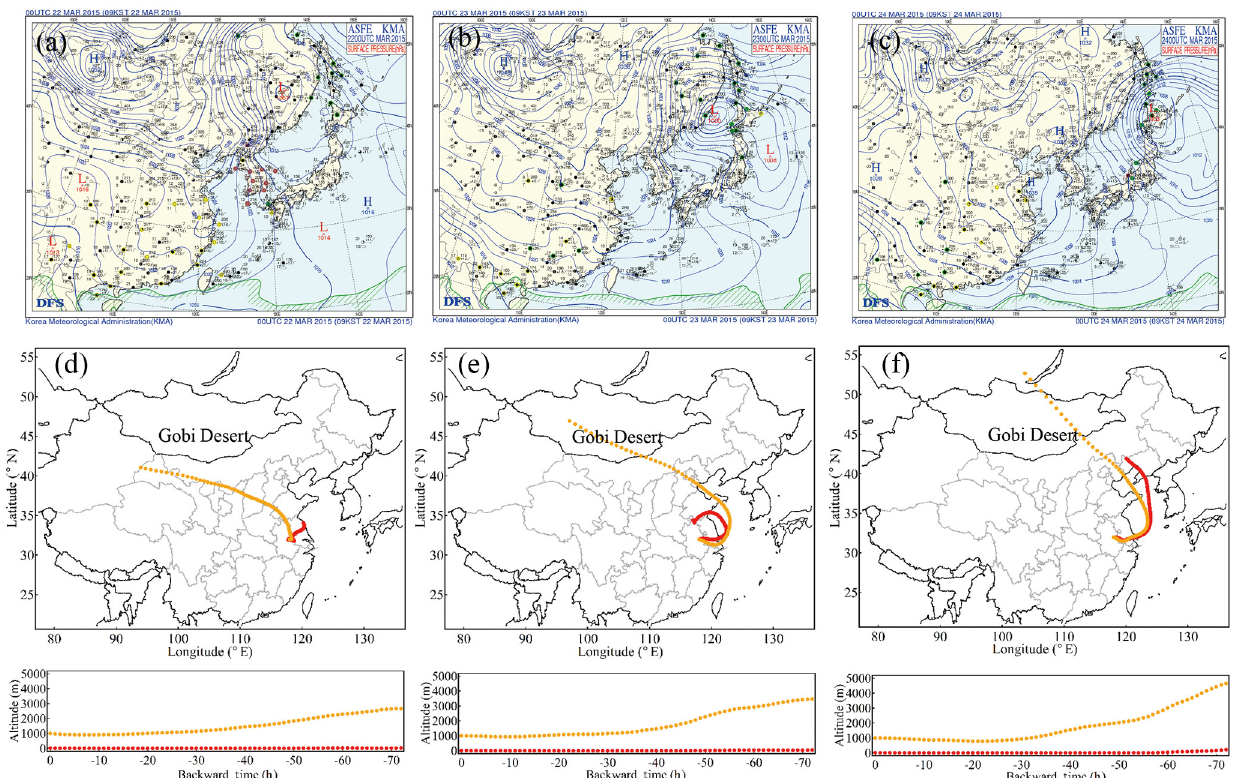
Figure 3. Weather charts and 3-day backward trajectories starting at altitudes of 10 and 1000m over Nanjing at 08:00LT on (a, d) 22, (b, e) 23 and (c, f) 24 March